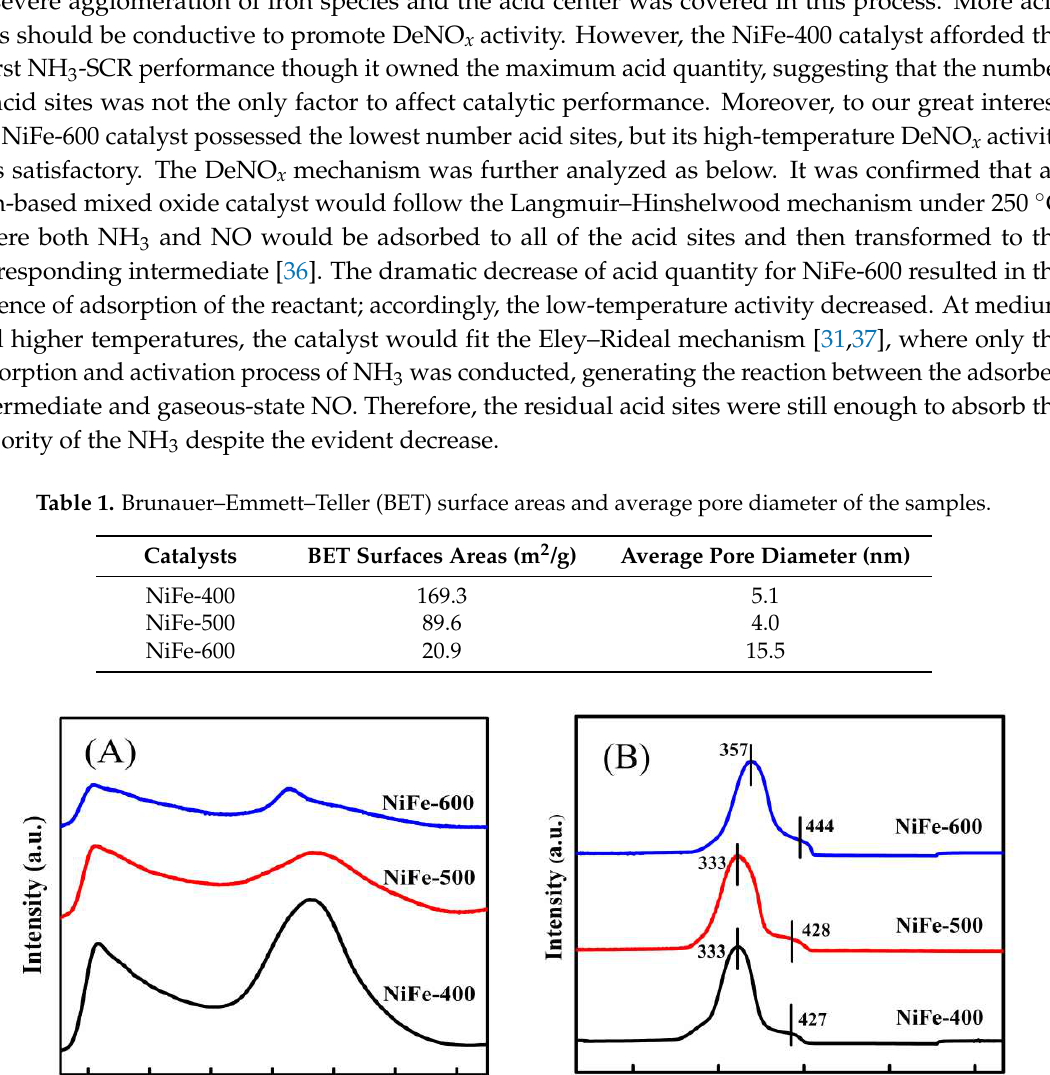
Table 2. Amount and proportion of NH 3 desorption of the serial catalysts.